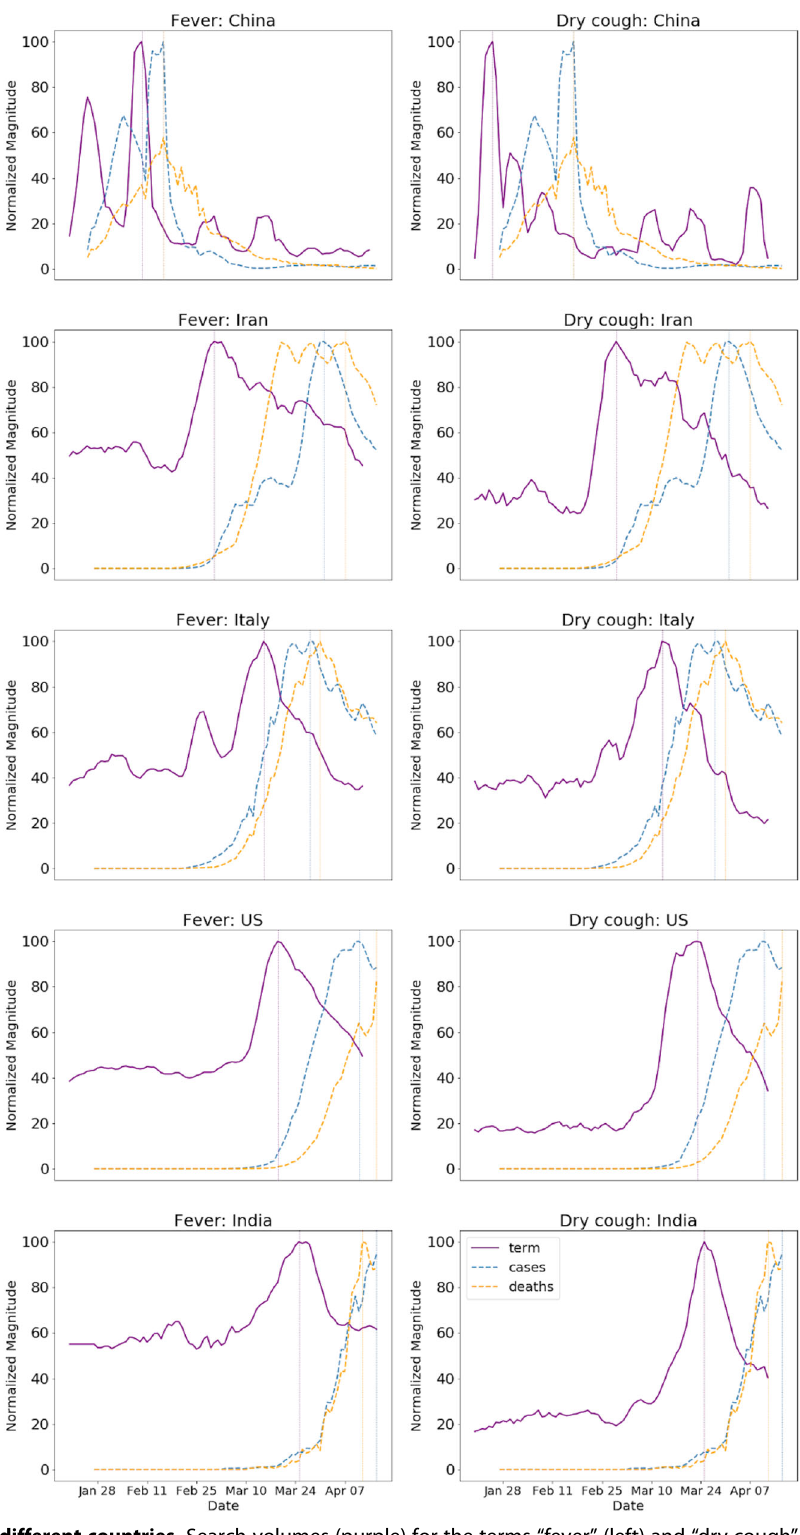
Fig. 1 Search volumes in different countries. Search volumes (purple) for the terms “ fever ” (left) and “ dry cough ” (right), alongside reported COVID-19 cases (cyan) and deaths (orange) for China, Iran, Italy, US and India. Even though outbreaks occur at different times in different countries, the relationships between the search terms and reported COVID-19 cases and deaths remain similar across countries. To highlight the temporal relationships between the curves, the magnitude of each curve was independently normalized to fi t the vertical dimensions of the